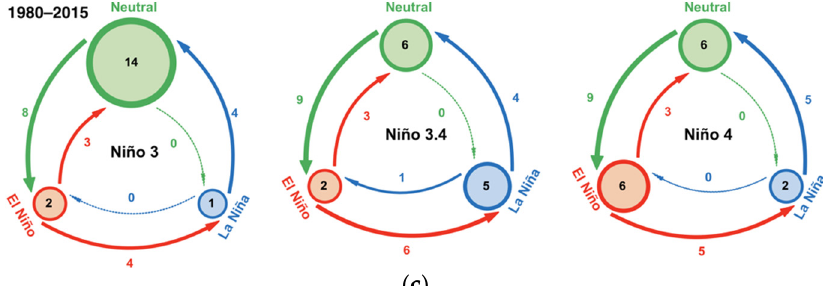
Figure 1. Estimates of frequency for different ENSO phase transitions characterized by various ENSO indices (Niño3, Niño3.4, Niño4) for the periods ( a ) 1891–2015; ( b ) 1950–2015; ( c ) 1980–2015.